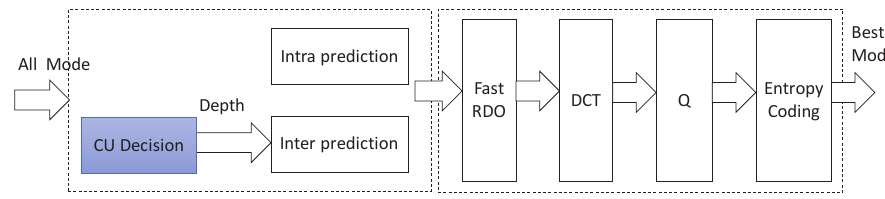
Figure 8. Mode decision process.